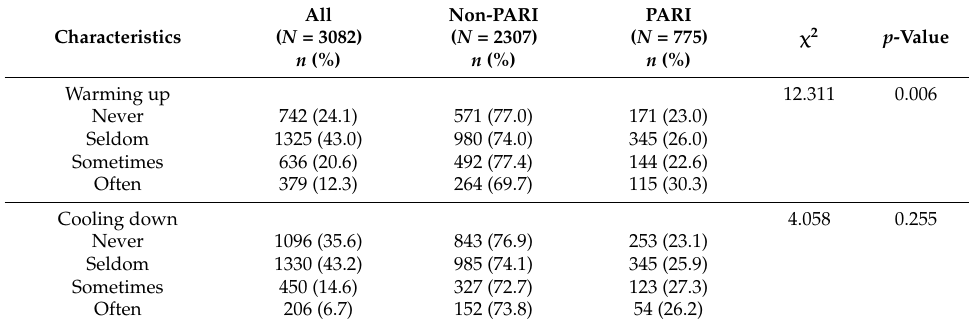
Table 2. Comparison of individual behavioral factors investigated involvement in physical activity (PA) in participants with physical activity-related injury (PARI) or